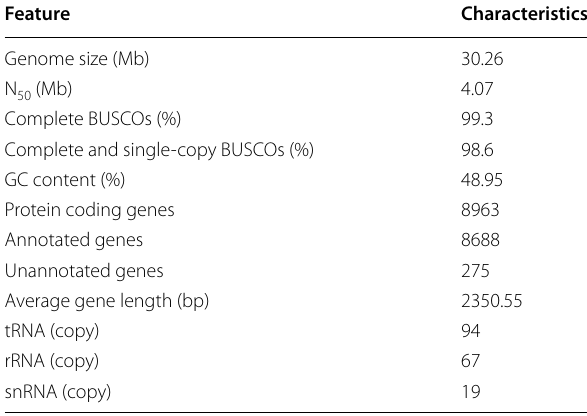
Table 1 Characteristics of S. aogashimaense